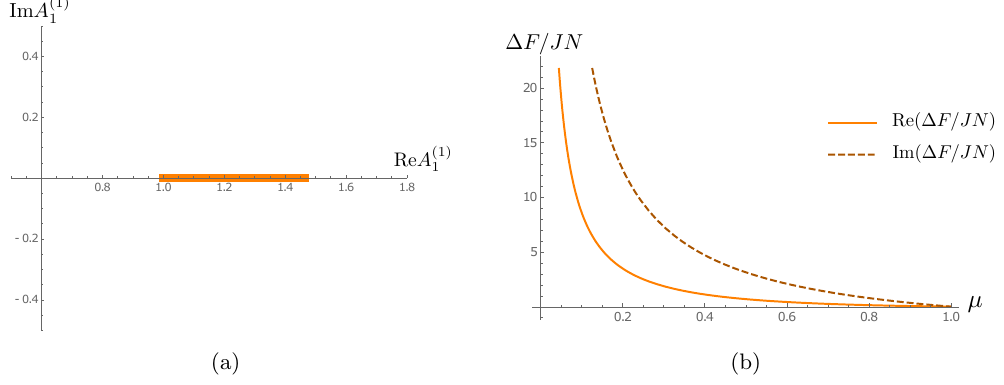
Figure 7 . (a) Trajectory of the saddle point (6.12) parametrized by µ on the complex plane. (b) The value of the free energy on solution (6.12), the solid line shows the real part and dashed line the imaginary